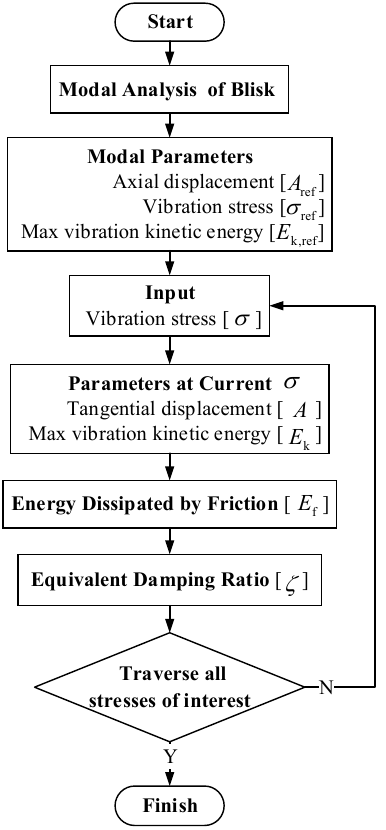
Figure 10. Flow of the damping characteristics of the ring. The Damping Characteristic Curve (DCC) is the damping ratio provided by the system with the vibration stress of the main structure at critical location, as shown in Figure 11. The critical vibration stress σ cr is the resonant vibration stress of the structure at critical location when the ring begins to provide damping. Peak damping ratio ζ max is the maximum damping rati, and σ m is the corresponding vibration stress. In addition, through the intersection of the curve of damping ratio on the vibration stress under excitation f e and DCC, the response under this excitation can be obtained. The vibration-reduction design flow of ring based on damping characteristics is shown in Figure 12. Adjust the design parameters of the ring to meet the design requirements: within the typical working range, the peak damping ratio shall be as large as possible, and the critical vibration stress shall be relatively